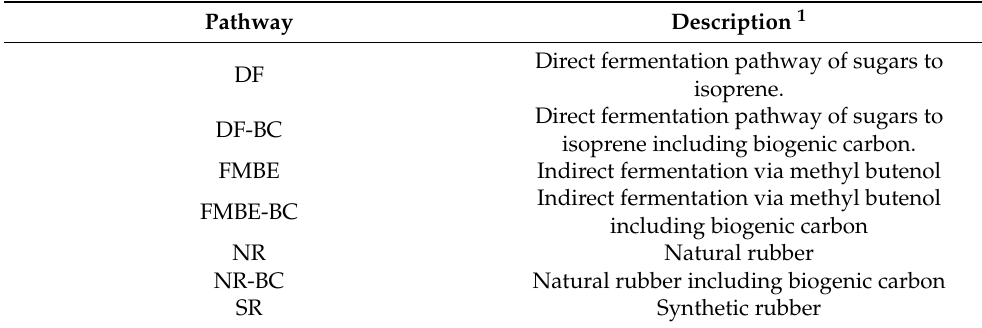
Table 4. Description of model cases: DF, FMBE, NR,